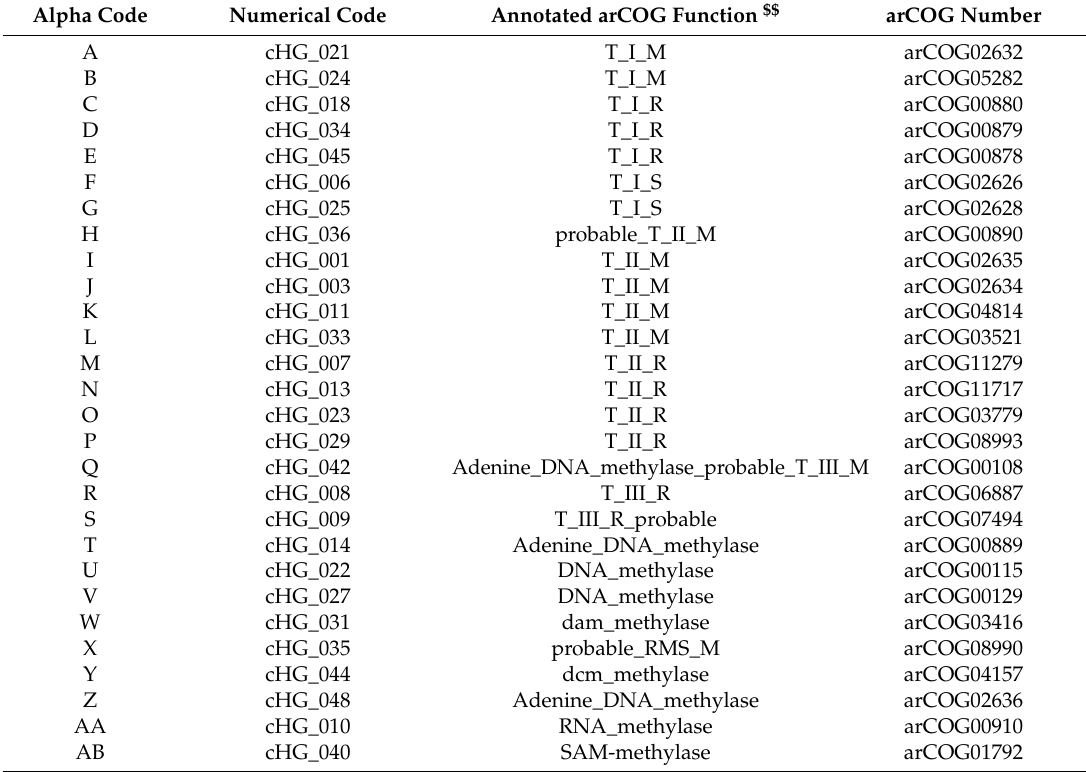
Table 1. Collapsed homologous group descriptions $